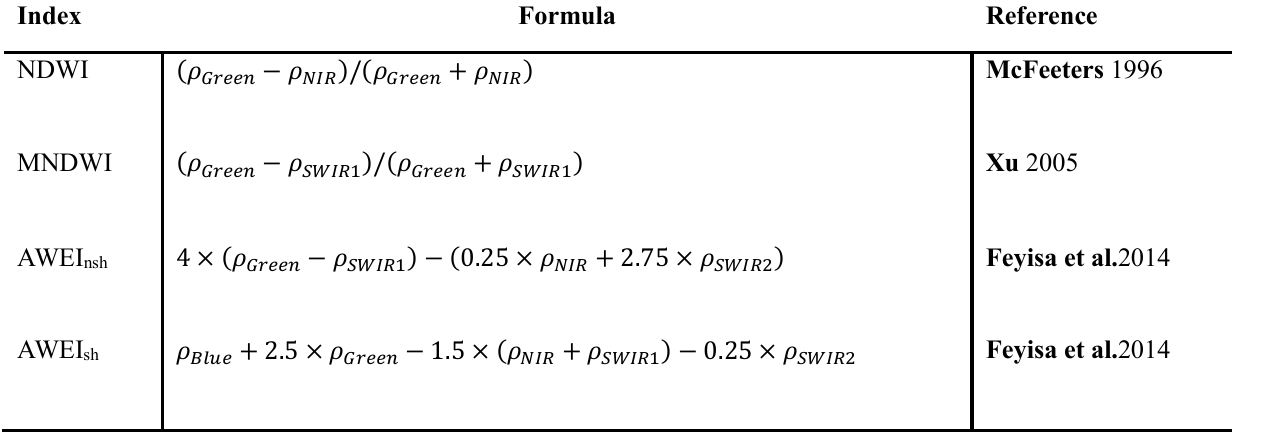
Table1. Common water indices used for the extraction of water features ( 𝜌 : the reflectance value of spectral bands) (2014) formulates a new method, called Automated water extraction index (AWEI) (Feyisa et al.,